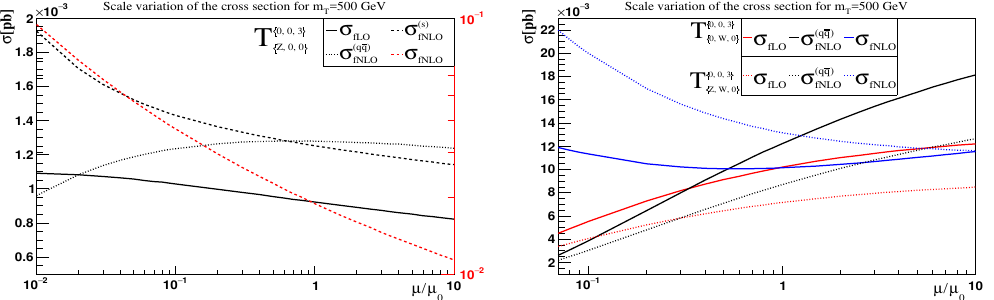
Figure 4 . Scale variation of the total cross section for the benchmark scenarios: T f 0 ; 0 ; 3 g and T f 0 ; 0 ; 3 g ( m = 500 GeV). We notice that the red-dashed plot on the left-side follows the T f Z ; W ; 0 g Y-axis on the right-side of the